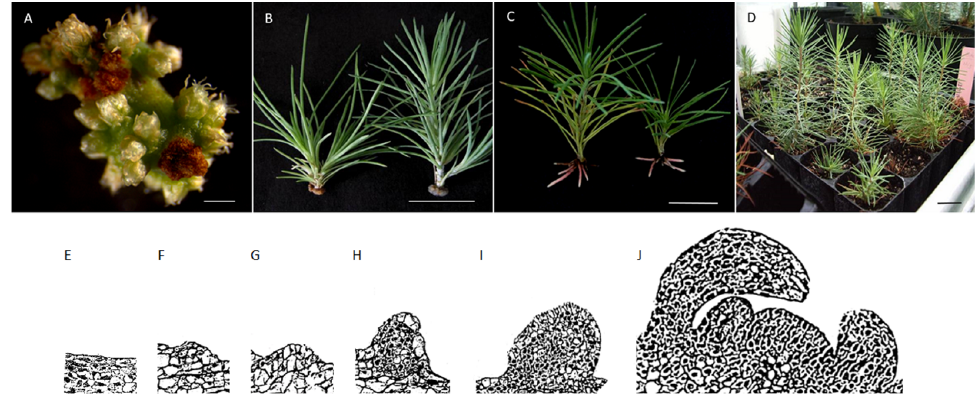
Figure 2. De novo organogenesis steps in Pinus pinaster . ( A ) Meristemoids formed on cotyledons excised from mature embryos that were cultured on the presence of N 6 —benzyladenine and subsequently transferred into a medium without plant growth regulators (PGRs). ( B ) Elongated adventitious shoots. ( C ) Rooted shoots obtained after the culture of the adventitious shoots in a medium containing 1-naphthalene acetic acid and their subsequent transference into a PGR-free medium. ( D ) Plantlets growing in the greenhouse for acclimatization. ( E – J ) Representation of the de novo meristem formation process, from promeristemoids to meristemoids forming needle primordia. Incubation of explants ( E ) on induction medium results in the formation of promeristemoids ( F – I ), which are cell clusters located within the first subepidermal cell layers of explants. They constitute the precursors of meristemoids ( J ), groups of small dense cells that arise in the explant and are determined to form adventitious shoot primordia when explants are transferred to a PGR-free medium. Bar 1 mm ( A ), 1 cm ( B – D ). Source: unpublished images from the authors.